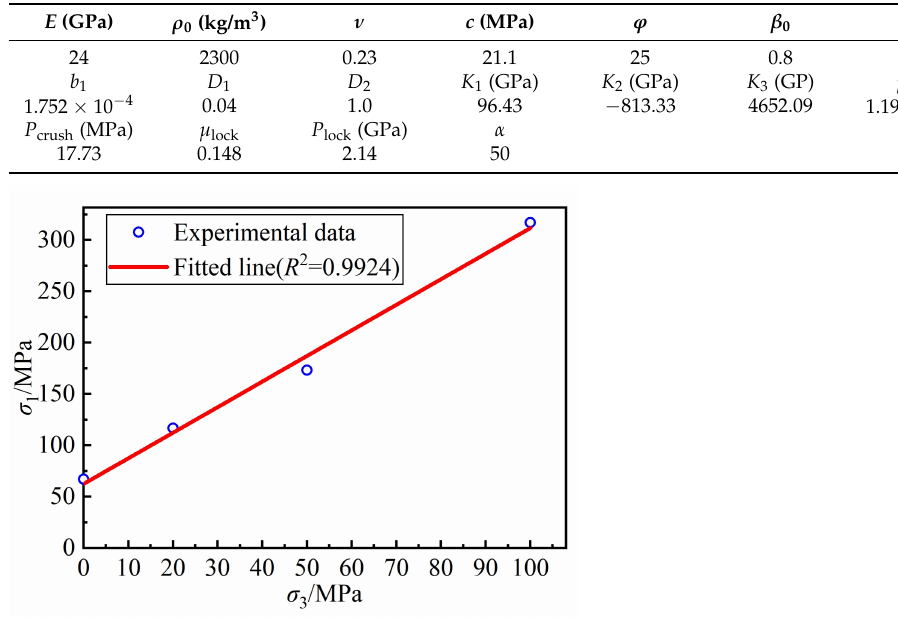
Figure 7. Relationship between σ 1 and σ 3 of Indiana limestone.